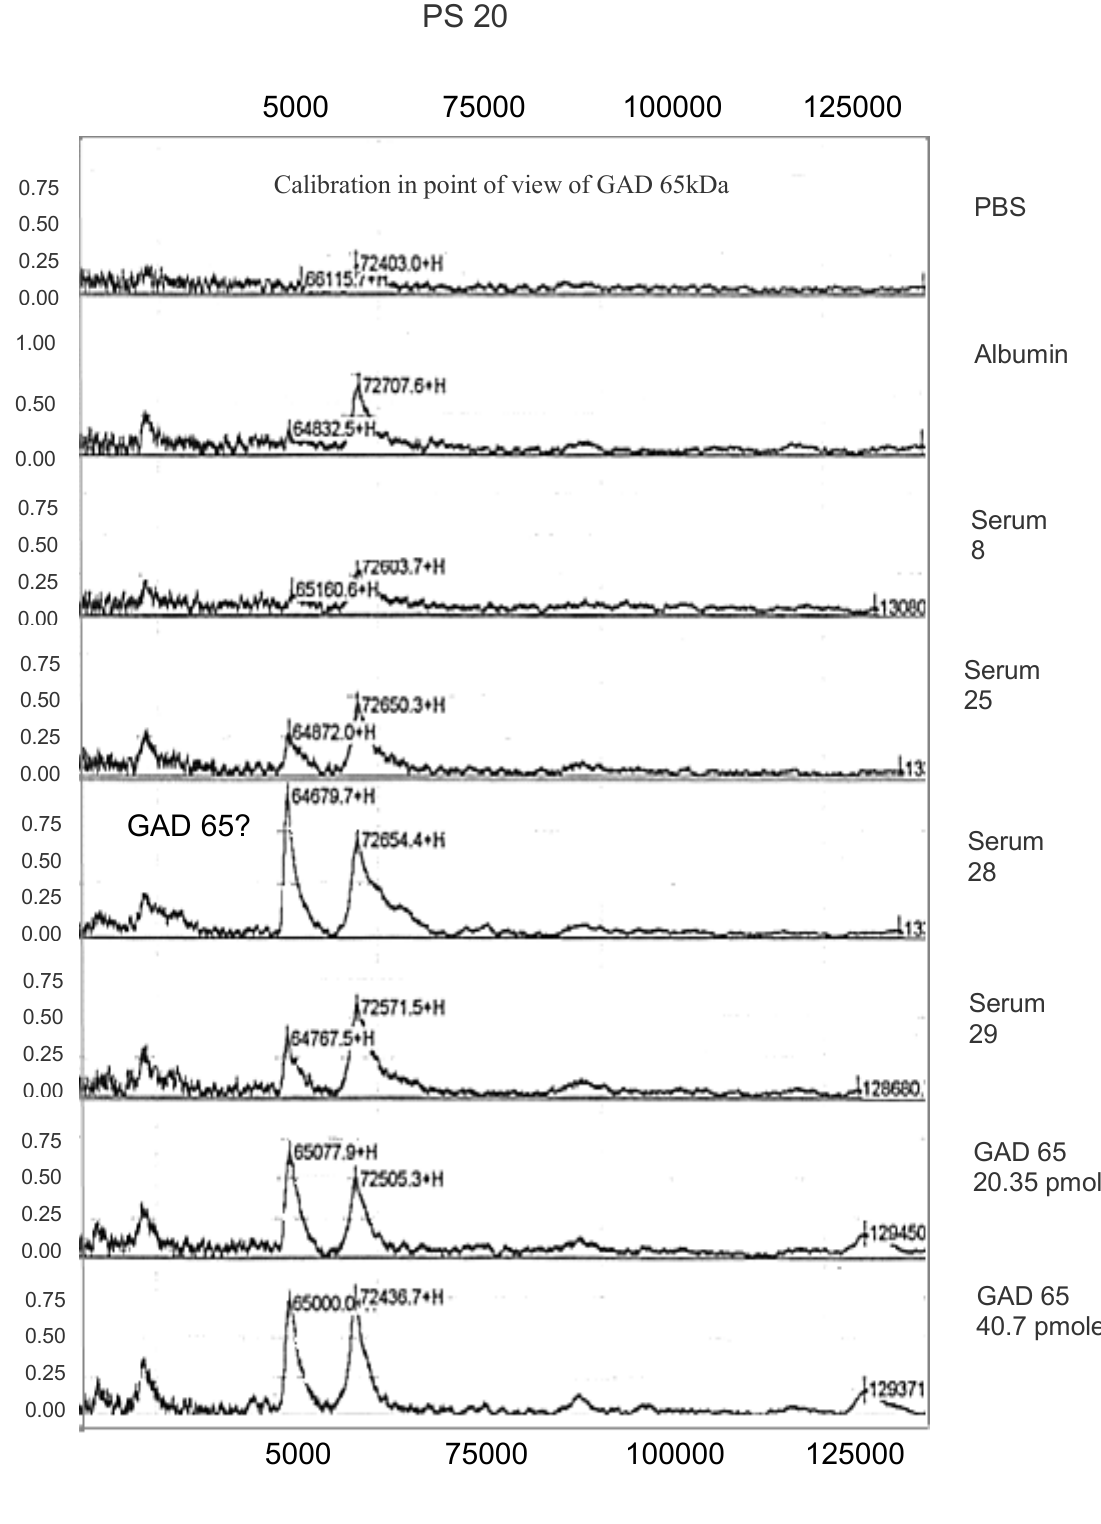
Figure 2. The sera are diluted at 1:20. The spectrum of the diluted serum 28 shows a peak at 65kDa which may results from GAD65. The intensity of the peak is greater, by a factor of 8.4, than the corresponding albumin peak. This serum is from a paediatric patient with diabetes mellitus type 1 at an early